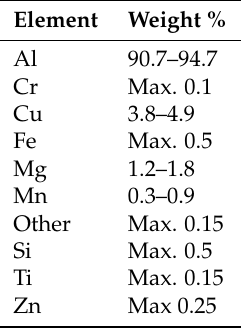
Table 5. Al 2024-T4 chemical composition [81].